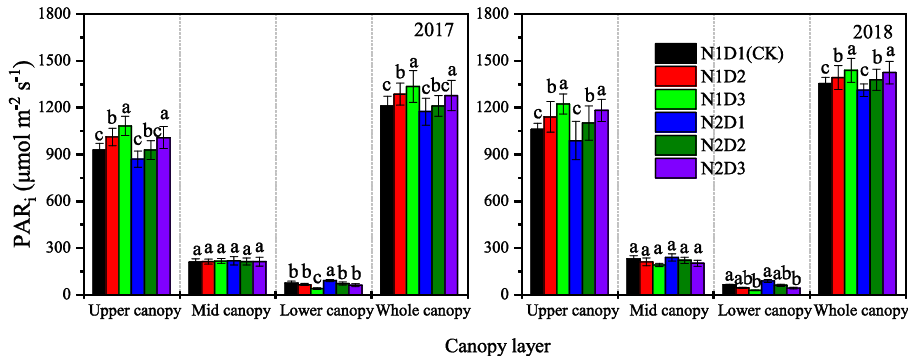
Figure 5. Vertical distribution of incident PAR intercepted (PAR i ) under different planting treatments at tasseling and silking stage. The data were averaged measurements on 45 and 60 DAE, 2017 and 50 and 65 DAE, 2018. Upper canopy, middle canopy and lower canopy of maize mean top-two leaves above the ear leaf, the ear leaf and two leaves above and below it, and two leaves below the ear leaf-bottom leaf, respectively. Each data point is the mean ± S.E. of three replications. Values followed by different letters within a column are significantly different ( P < 0.05).